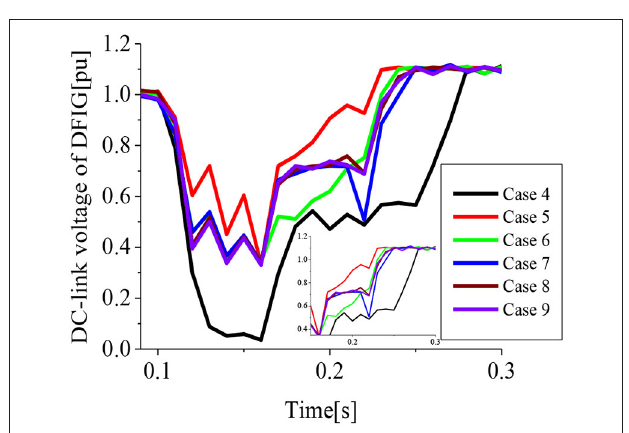
FIGURE 11 | Rotor speed of DFIG (cases 1–3).